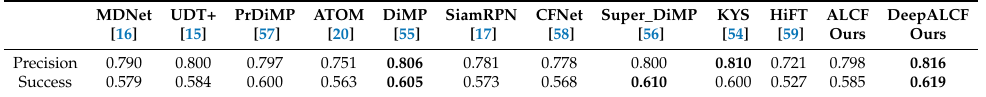
Table 3. Performance comparison of ALCF with other ten state-of-the-art deep trackers (top 3 in bold ).